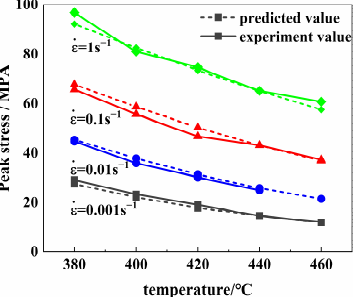
Figure 5. Comparison of peak stress between experiment value and predicted value.